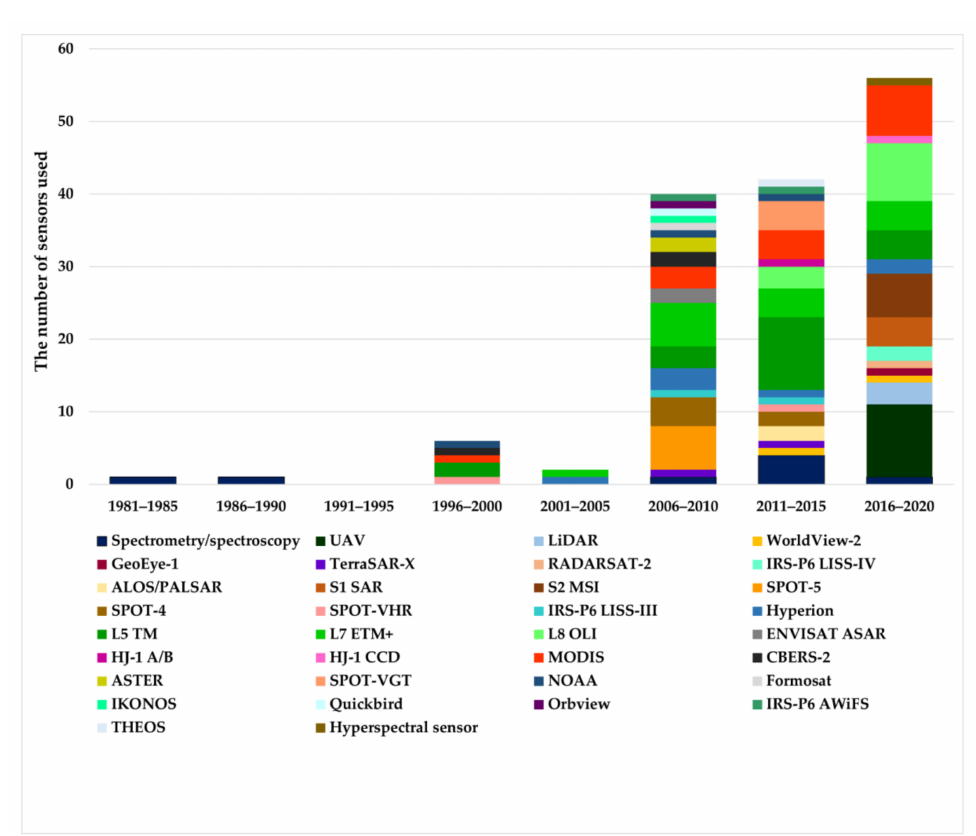
Figure 13. Number of sensors used vs. temporal ranges in five years. Table 3. The detail of sensors used in intervals of five years and frequency studies in percentage. Time Intervals